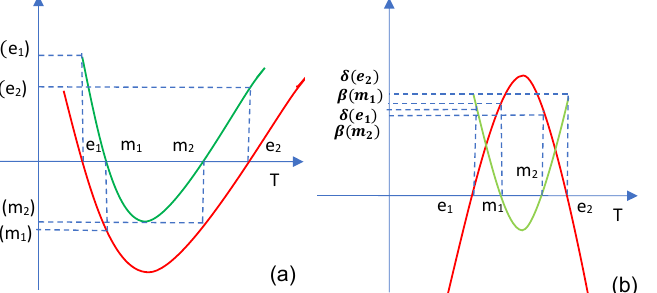
Figure 3. Graphical representation of ∆ 1,2 . Case III ( e 1 < m 1 < m 2 < e 2 ): ( a ) a > 0, h > 0; ( b ) a < 0, h >